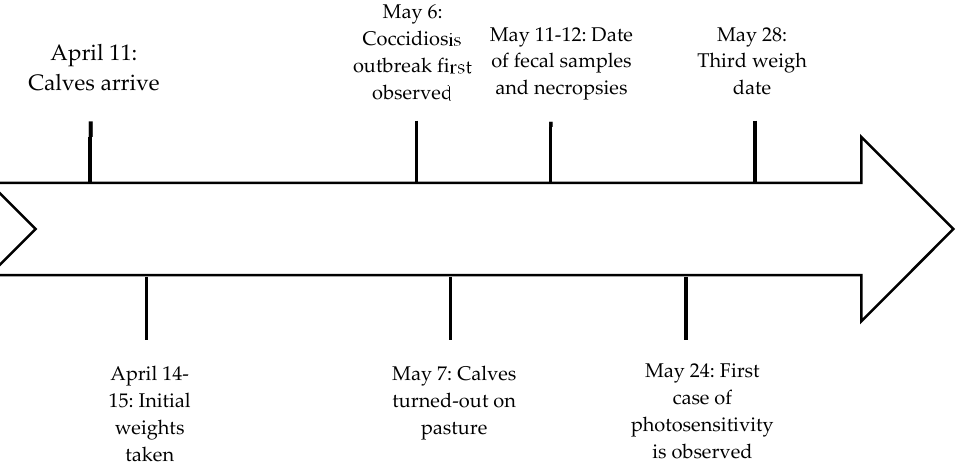
Figure 1. Timeline for important dates related to symptom observation and sampling.